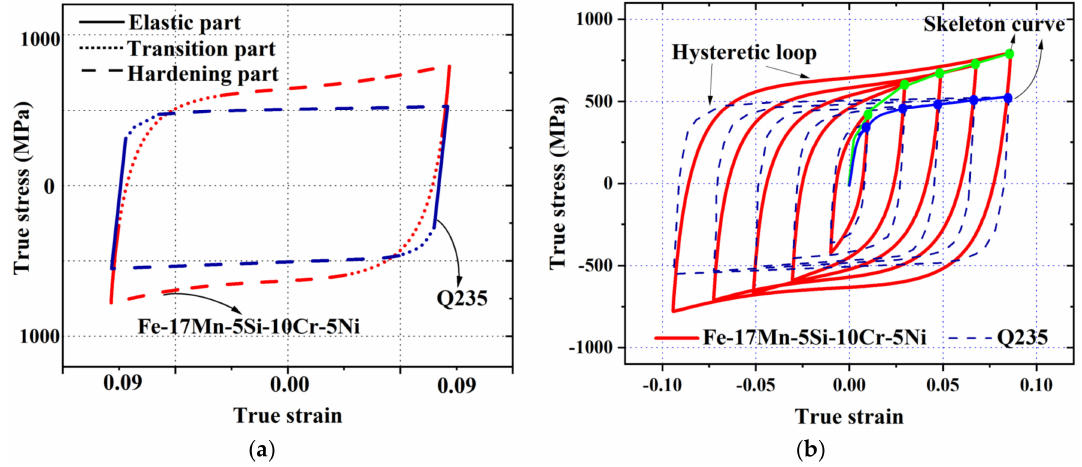
Figure 8. Comparison of ( a ) Decomposed hysteretic loops; and ( b ) Skeleton curves obtained from stabilized hysteretic loops of Fe-17Mn-5Si-10Cr-5Ni and mild steel (Q235). Researchers have reported that the hysteretic loops of Fe-SMA can quickly saturate regardless of the strain range so that the peak stress is stable until failure [23].